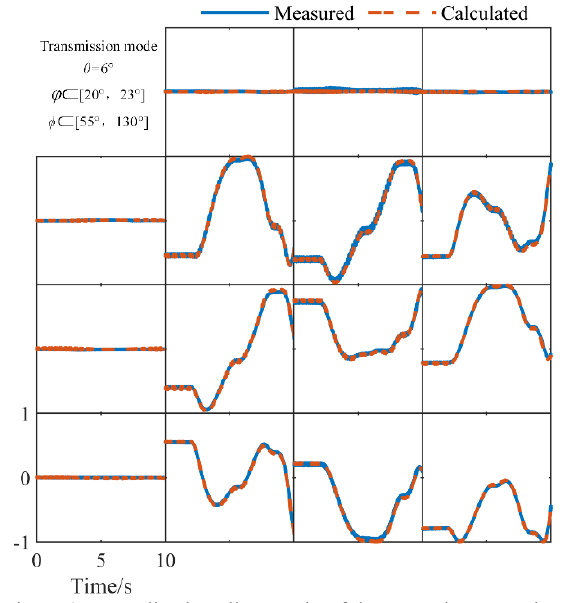
Figure 8 Normalized Muller matrix of the waveplate over time in the oblique incidence dynamic experiment.